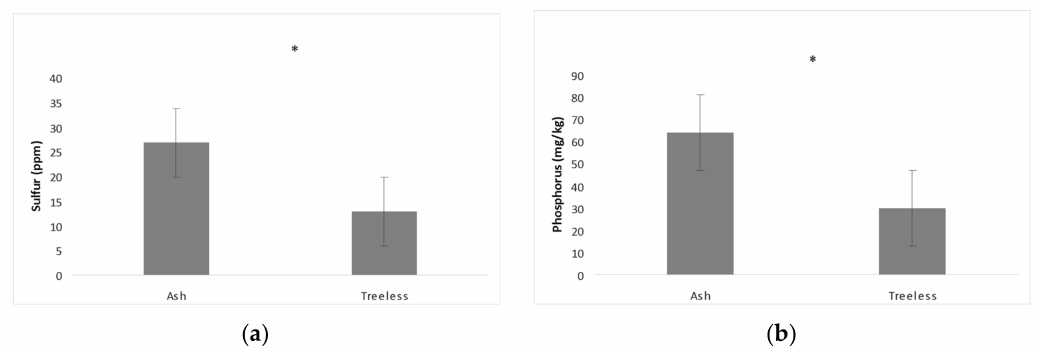
Figure 2. Differences in soil nutrient analysis between ash tree soil samples and treeless soil samples were found to be significantly different (* represent p < 0.0001) for: ( a ) Sulfur (ppm) and; ( b ) Phosphorus